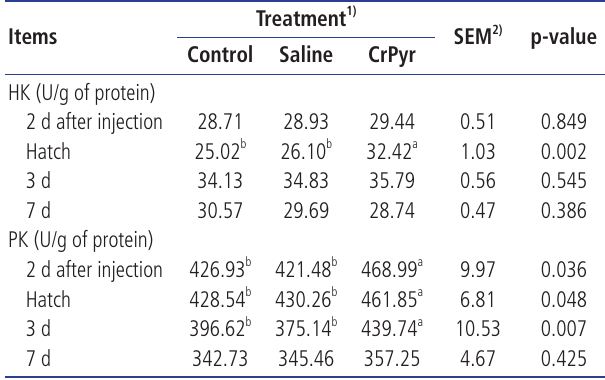
Table 5. Effects of in ovo feeding of creatine pyruvate on the concentration of creatine and phosphocreatine in thigh muscle of embryos and broilers on 2 d after injection, the day of hatch, 3, and 7 d post-hatch Treatment 1) Items